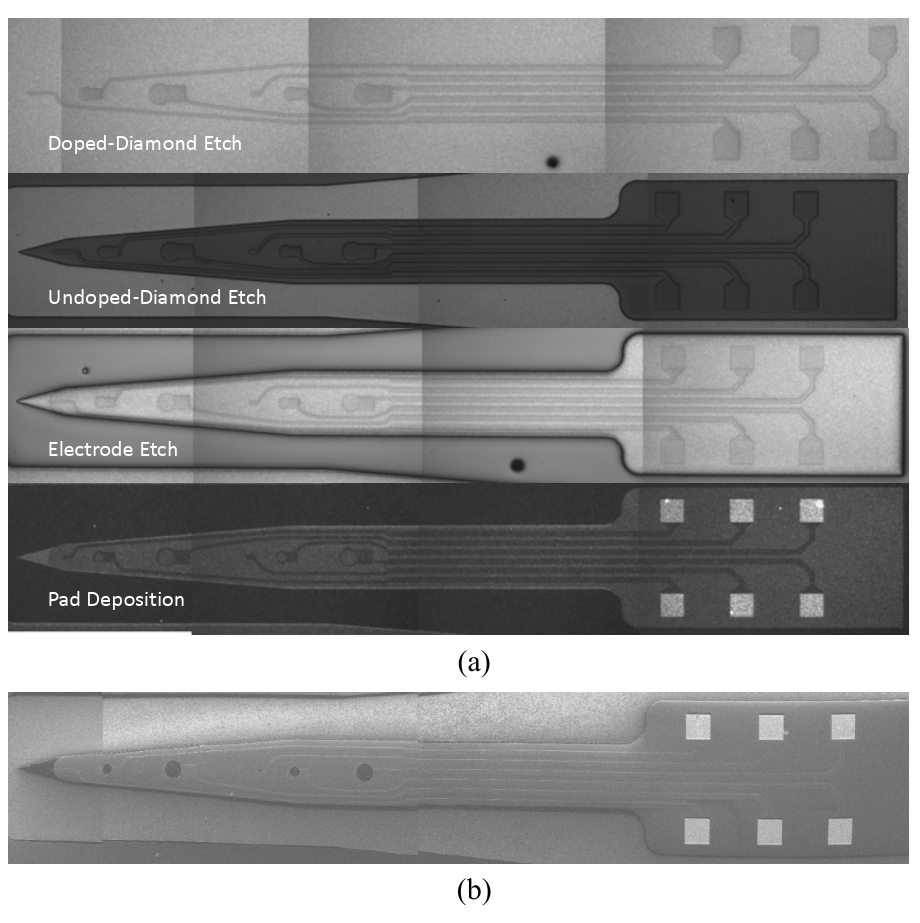
Figure 4. Micrographs of all-diamond neural probe fabrication. ( a ) Optical micrographs showing key fabrication steps; ( b ) Scanning electron micrograph showing the finished probe before release in